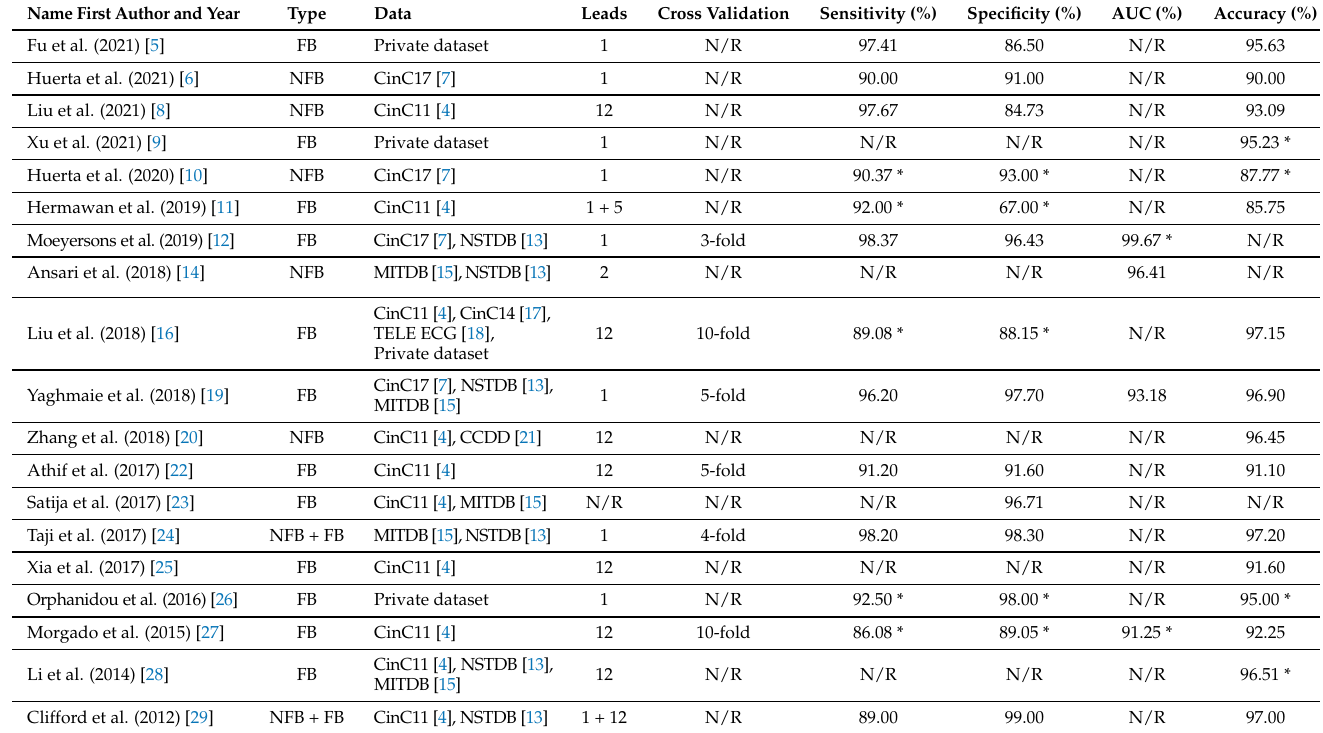
Table 1. Summary of all the identified publications on ECG quality assessment techniques. Note that FB refers to feature-based and NFB refers to non-feature-based. N/R refers to not received, meaning that the value was not mentioned in the article. The values have been averaged for studies that reported multiple results. * Averaged value .